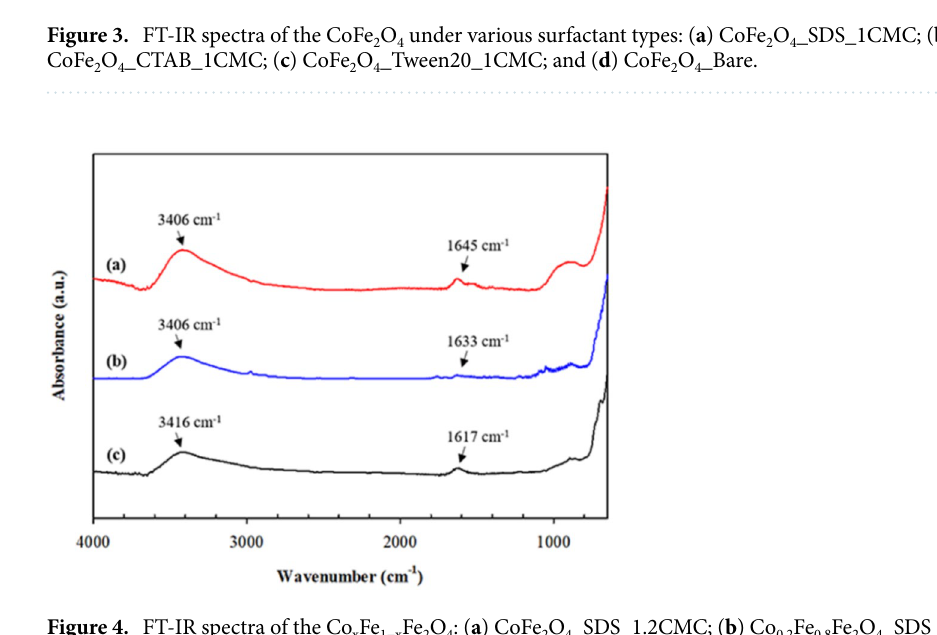
Figure 4. FT-IR spectra of the Co x Fe 1−x Fe 2 O 4 : ( a ) CoFe 2 O 4 _SDS_1.2CMC; ( b ) Co 0.2 Fe 0.8 Fe 2 O 4 _SDS_1.2CMC; and ( c)